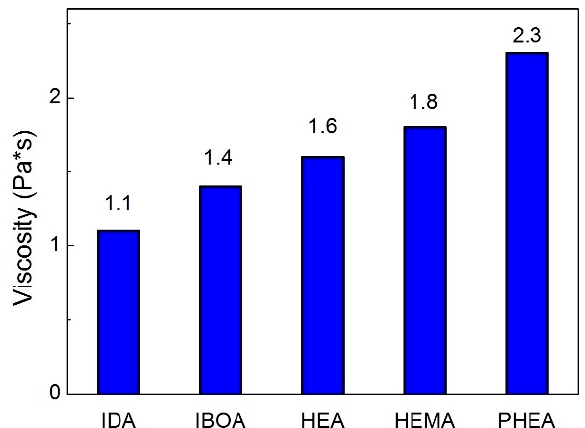
Figure 4. Viscosity of different acrylic monomers with 20 vol.% of 8YSZ at shear rate of 30 s − 1 at 20 ◦ C. The suspensions with IDA and IBOA indicated the lowest viscosity (1.1 and 1.4 Pa · s at shear rate of 30 s − 1 , respectively) and shear thinning behavior at either higher or lower shear rates among the studied monomers. The same trend was also observed with the additions of BYK w969. Note that pure monoacrylic monomers are quite difficult to cure. In this case, it is necessary to add some amount of crosslinking agent into a slurry. TMPTA was found to be a good component for facilitating the photocuring reaction